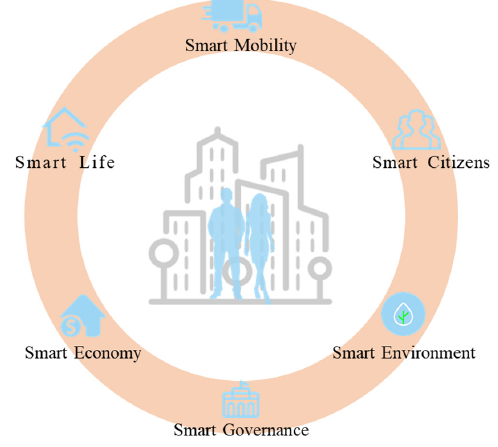
Figure 1. The six areas of smart city construction.